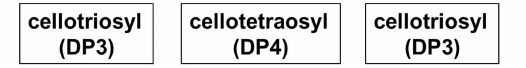
is appended single α - L -arabinofuranosyl (Ara f ), single α - D - glucuronopyranosyl (Glc p A) residues, or the 4- O -methyl ethers of Glc p A residues (Izydorczyk and Biliaderis, 1994; Fincher and Stone, 2004). In some cases oligosaccharide substituents such as β - D -Xyl p -(1,2)- L -Ara f -(1- and β - D -Gal p (1,4)- β - D -Xyl p -(1,2)- L -Ara f -(1- are also detected in heteroxylans (Fincher and Stone, 2004). The Ara f residues are usually linked to the C(O)3 posi- tion of the Xyl p residues, but on occasions are found on C(O)2 or on both of these carbon atoms. The Glc p A residues are usually linked to the C(O)2 atom of the Xyl p residues. The struc- tural features of plant heteroxylans are summarized in Figure 1